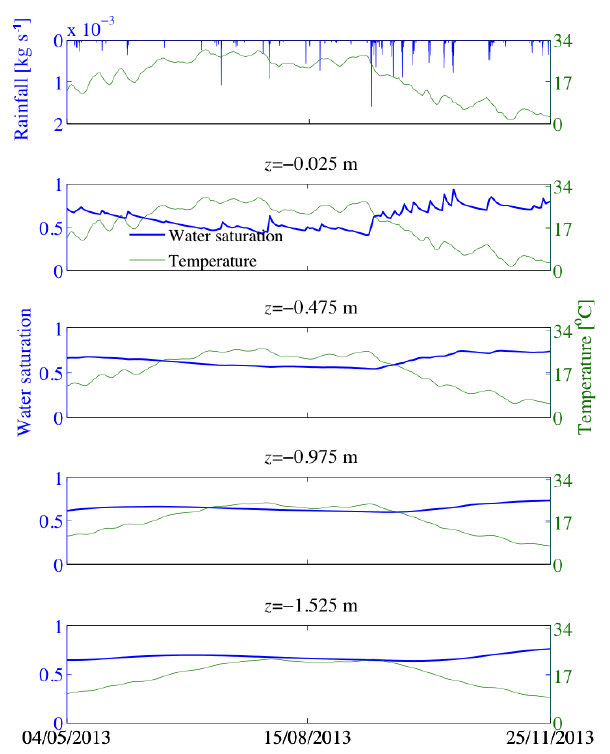
Figure 8. Temporal variation of the simulated water saturation and temperature at depths z = 0.025, 0.475, 0.975 and 1.525m of the TT02 well (center of the computational domain). For reference, rainfall and soil surface temperature data are also plotted.